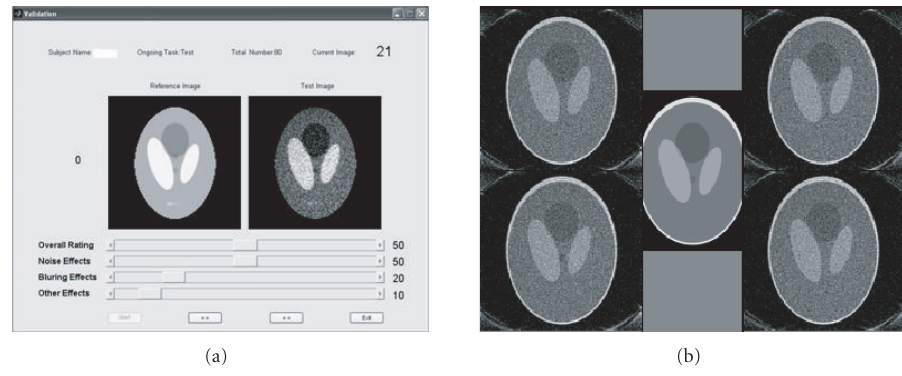
Figure 3: Screen shots showing methods for human subject evaluation of image quality. In the modified DSCQS experiment (a), subjects scored a test image relative to the reference. Note that only the region of interest over the “head” is shown and that other regions are blocked. In the adaptive 4-AFC experiment (b), the subject must choose which of the four panels contains the lesion and mark it with a cursor. (The answer is the lower left-hand corner.) The center image is a reference showing the location of the